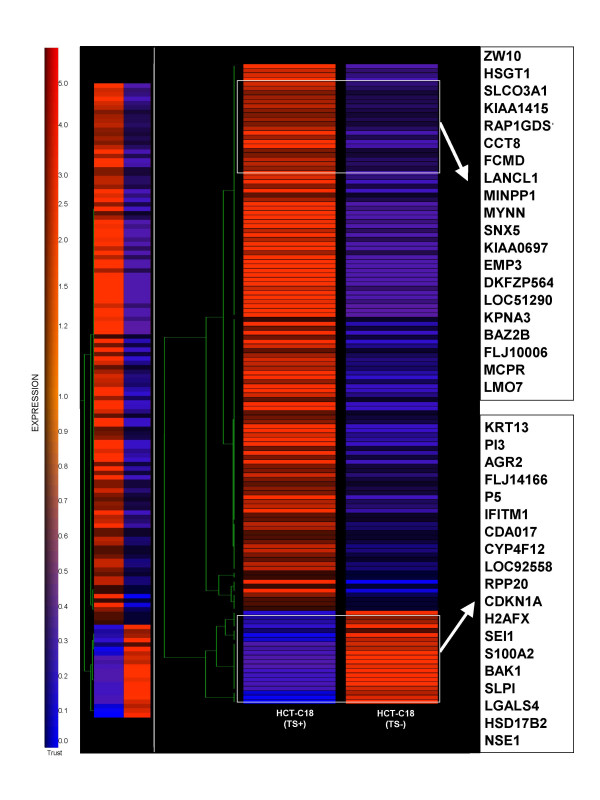
Clustering analysis of genes expression affected by TS overexpression with HCT-C18 (TS+) (Lane 1) vs. HCT-C18 (TS-) (Lane 2) based on the profiles of polysome associated mRNAs. One-way ANOVA analysis was used for the gene clustering with p < 0.05.